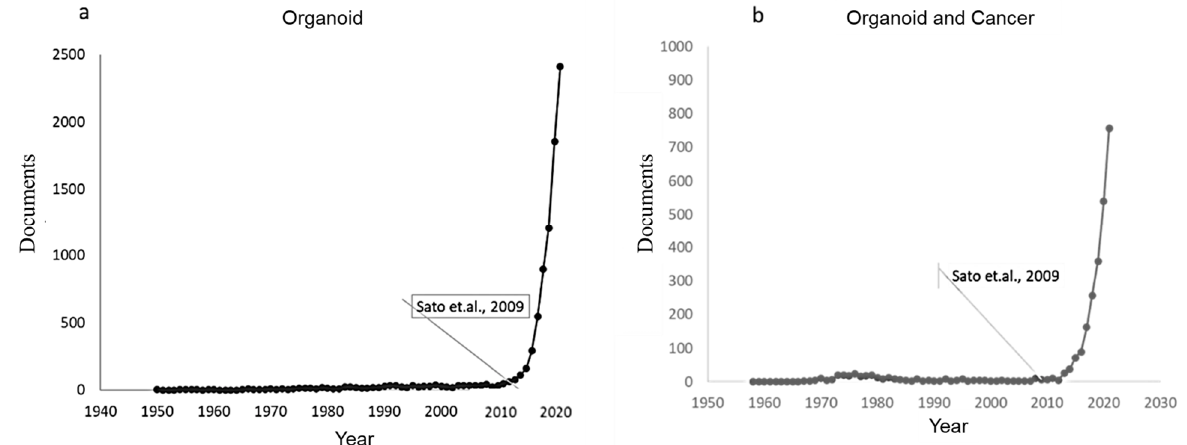
Figure 1. Documents published with reference to the topics of interest. ( a ): Publications over time of the organoid topic. ( b ): Publications over time of the organoid and organoid/cancer topics. For this, a search was performed in the SCOPUS, Nature, and Science-direct databases using the keywords “Organoid” AND “Cancer” AND “Characterization” as the search equation, and selecting the documents of interest from the titles and abstracts [16].